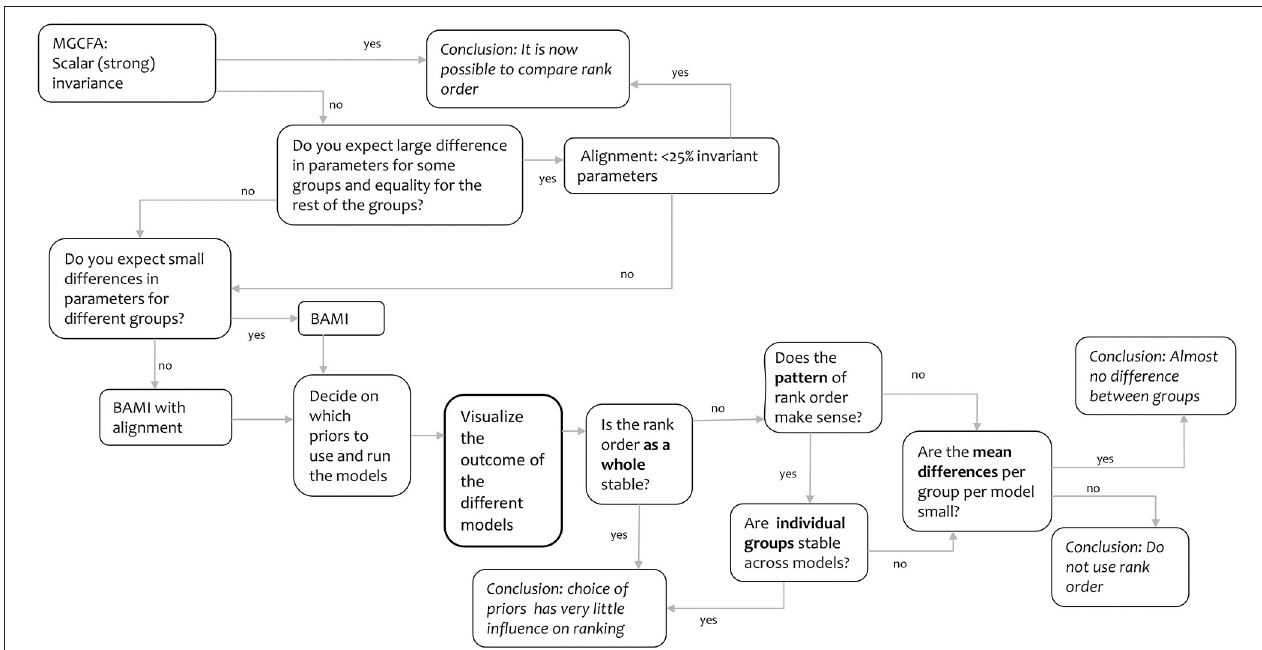
FIGURE 5 | Decision